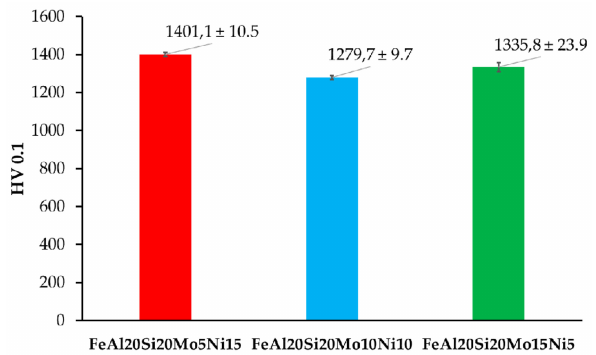
Figure 5. Vickers hardness of the prepared MA + SPS FeAl20Si20-Mo-Ni alloys.